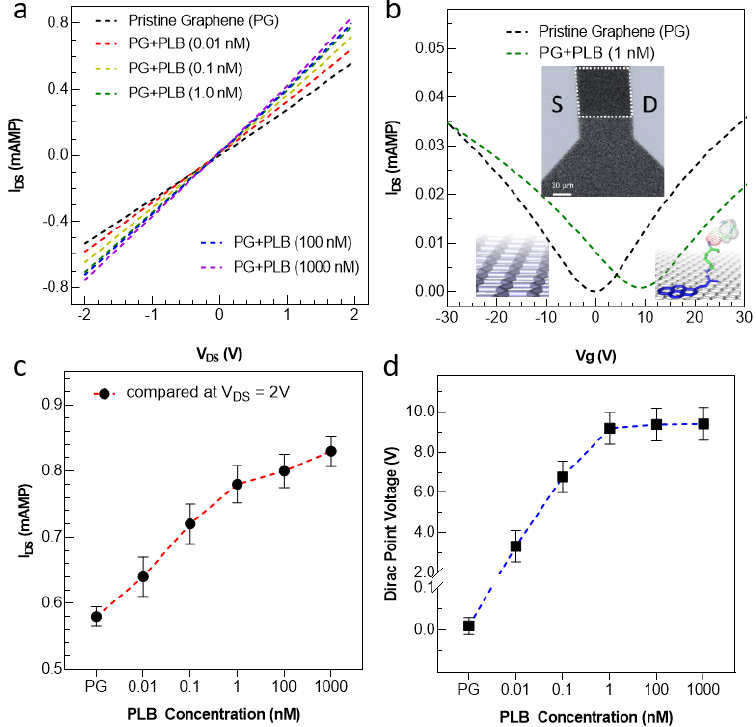
Figure 4. Electrical property analysis of the device before and after functionalizing with our PLB construct at various concentrations. ( a ) The output characteristics (at V g = 0 V) of the device before and after functionalization. The current increases upon functionalization due to transfer of free elec- trons from pyrene to graphene. ( b ) The transfer characteristic of the device before and after func- tionalization. The Dirac point lies around 0 V, showing perfect growth and transfer procedure with- out any serious external doping. After functionalization, a clear shift in DIRAC point voltage was observed, owing to the p-doping of graphene upon functionalization. The SEM image of the final graphene FET device is shown in the inset with a scale bar of 10 µm. The white dotted rectangular region shows the graphene channel area. ( c,d ) A relative increase in current at (V DS = 2 V) and Dirac point voltage V DS = 0.01 V) was achieved by increasing the concentration of PLB.